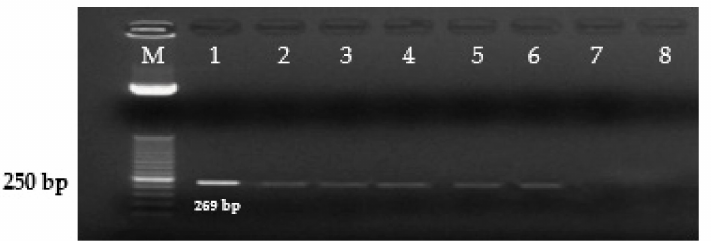
Figure 4. Detection of S. Virchow using PCR primers SV CRISPR–1F and SV CRISPR–1R (269 bp). Lane M—50 bp ladder (Invitrogen). Lane 1—PCR products amplified from S. Virchow, reference strain (positive control). Lanes 2, 3, 4, 5, 6—clinical samples, positive for S. Virchow , lane 7— S. Enteritidis (S.e-0071), lane 8— S. Typhimurium